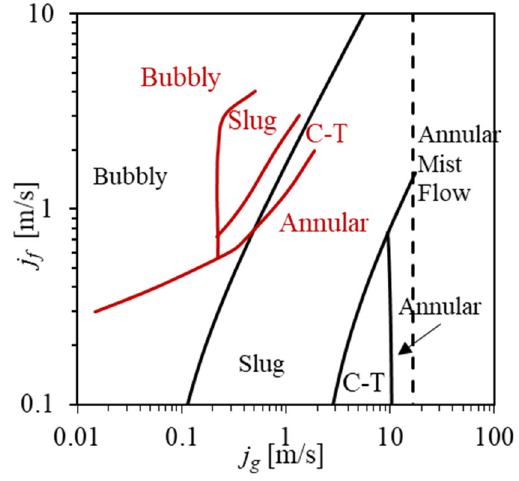
Figure 5. Comparison of two ‐ phase flow regimes of the VU flow by Mishima and Ishii [7] and VD flow by the authors [32]. flow by the authors